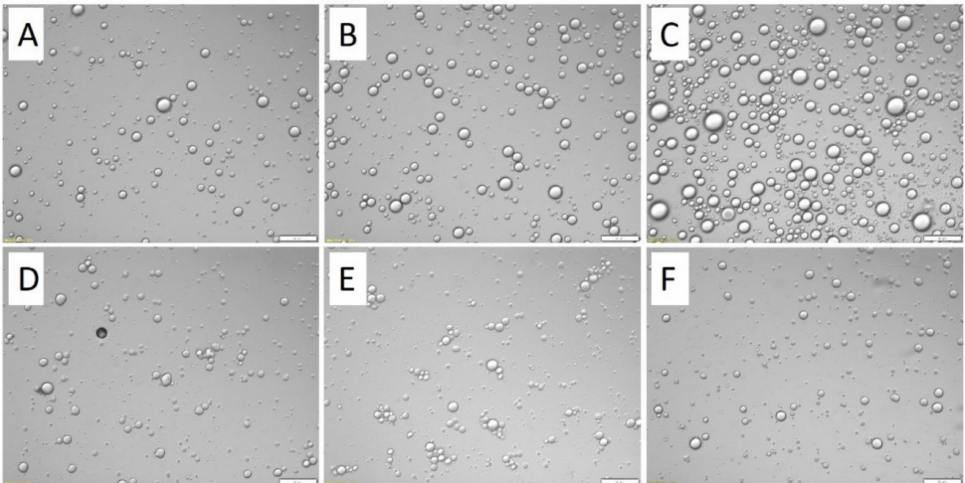
Figure 6. Optical microscopy images of peppermint oil complex coacervate microcapsules with different concentrations of crosslinker before (upper row) and after (bottom row) spray drying. The polymer concentration and Polymer:Oil ratio was held constant at 6% and 2:1, respectively. ( A , D ) = 2.5% crosslinker, ( B , E ) = 5% crosslinker, ( C , F ) = 10% crosslinker. The scale bar corresponds to 50 µ